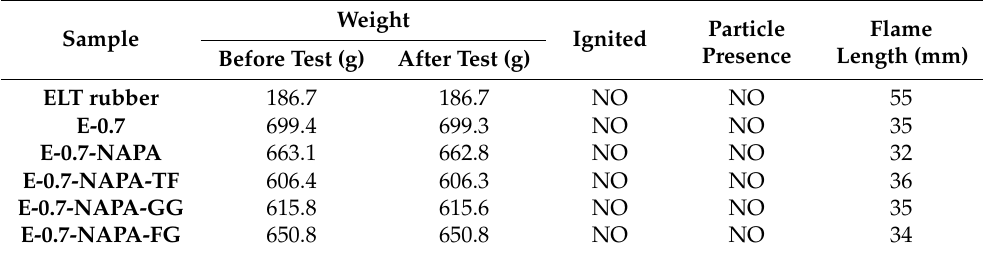
Table 10. Fire Ignitability test